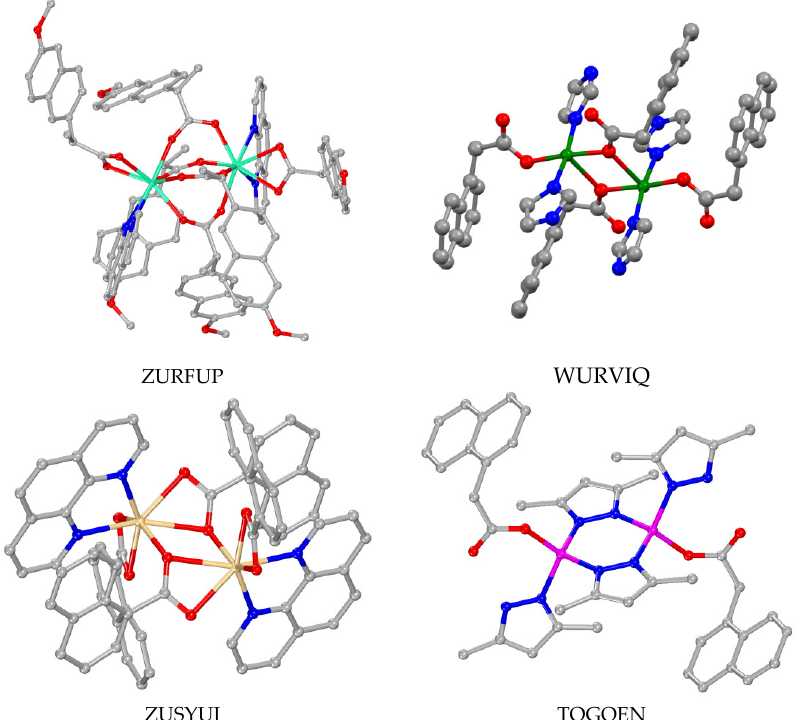
Figure 20. Molecular structures of selected complexes with coordination modes III–VI of Table 2. ZURFUP = [Dy 2 (µ 2 –NAP–O,O′) 4 (NAP–O,O′) 2 (phen) 2 ] (mode III: bidentate bridging (µ–Ο,Ο’) and bidentate chelating) [82]; WURVIQ = [Cu 2 (µ 2 –N1A–O,O) 2 (N1A–O) 2 (Himi) 4 ] (mode IV: bidentate bridging (µ–Ο,Ο) and monodentate binding) [83]; ZUSYUJ = [Cd 2 (µ 2 –N1A–O,O,O′) 2 (κ–N1A–O,O′) 2 (phen) 2 ] (mode V: tridentate bridging (µ–O,O,O′) and bidentate chelating) [84] and TOGQEN = [Zn 2 (µ–dmpz) 2 (Hdmpz) 2 (N1A–O) 2 ] (mode VI: monodentate binding, bridging from other co-ligand) [85]. Hydrogen atoms, disordered atoms and solvate molecules are omitted for clarity reasons. Color code for atoms: C: gray, O: red, N: blue, Cd: yellow; Cu: green; Dy: light green and Zn: magenta. The figures of the structures were adapted from the corresponding references.